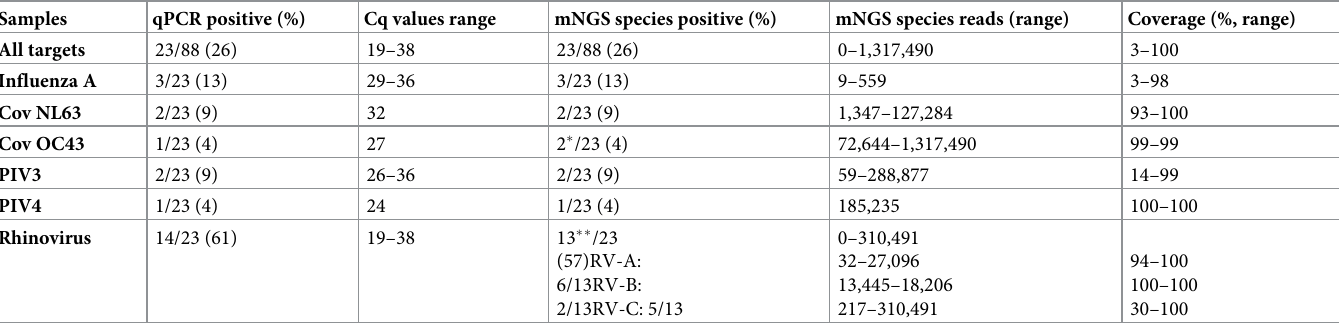
Table 3. qPCR positive samples with respective mNGS results.